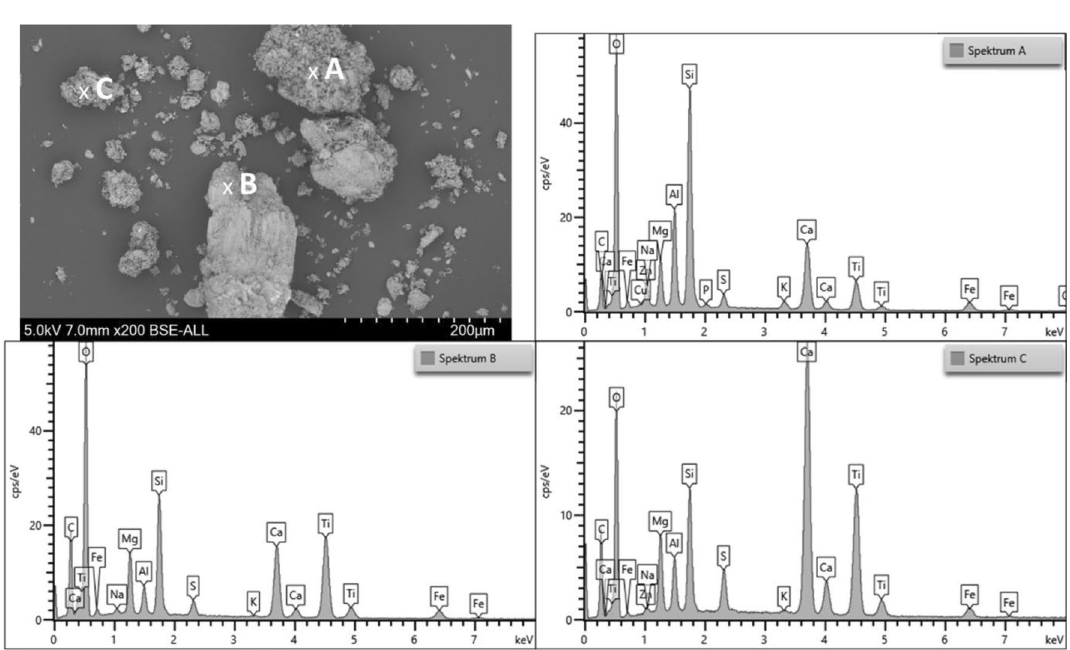
Figure 10. Elemental spectra of TWAP after calcination on different